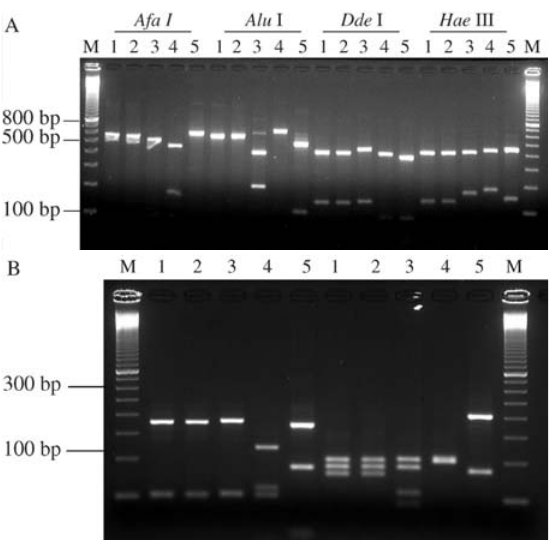
Figure 1 - PCR-RFLP of the ITS1 – 5.8S – ITS4 region digested with (A) Afa I, Alu I, Dde Iand Hae III,and(B) Hpa IIe Sau 3AI.1= Metarhizium anisopliae var. anisopliae strainE 9 ;2= M.a.anisopliae strainC;3= M.a. anisopliae strain 14; 4 = Metarhizium album strain 201; (5) Metarhizium flavoviride strain 204. M = 100 bp marker.